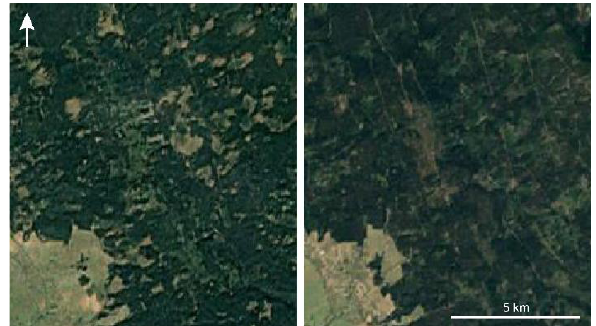
Figure 2 . Landsat image of a part of AOI acquired in 2000 (left panel) and 2020 (right panel). Several forest-free areas are visible in the left image. However, in the